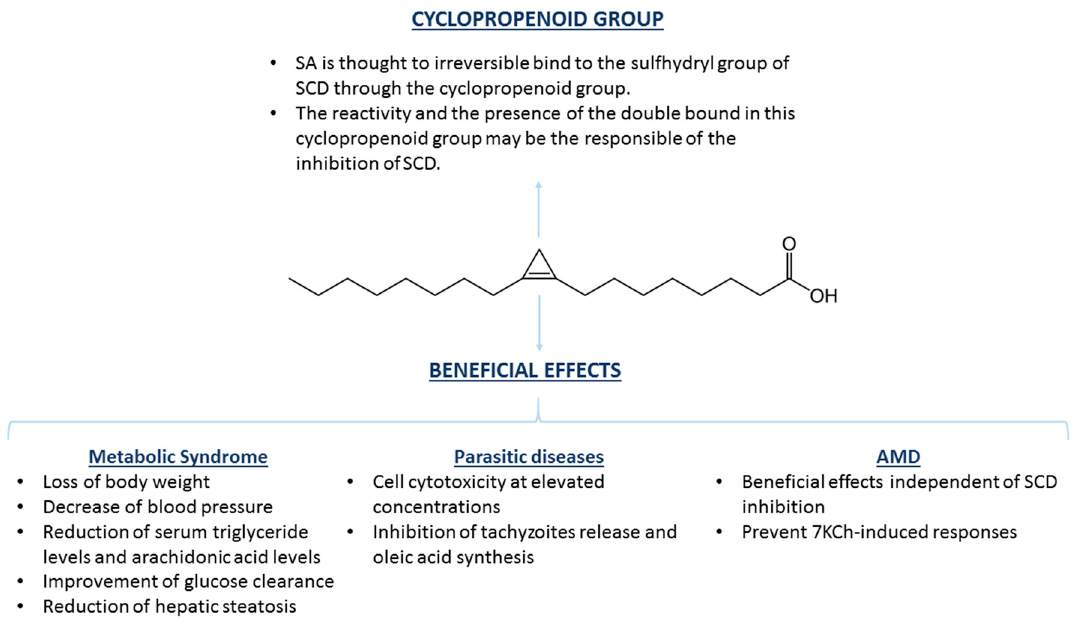
Figure 3. Chemical structure of SA and beneficial effects exerted in several pathologies. The cyclopropene group of SA has been suggested to be responsible for both binding and inhibition of SCD as a consequence of the reactivity of the double bond between C9 and C10. Inhibition of SCD by SA has been described as potentially therapeutic for several diseases, such as those related with metabolic syndrome and parasitic diseases. Positive effects of SA have also been shown in age-related macular degeneration (AMD), although the effects seem to be independent of SCD inhibition.